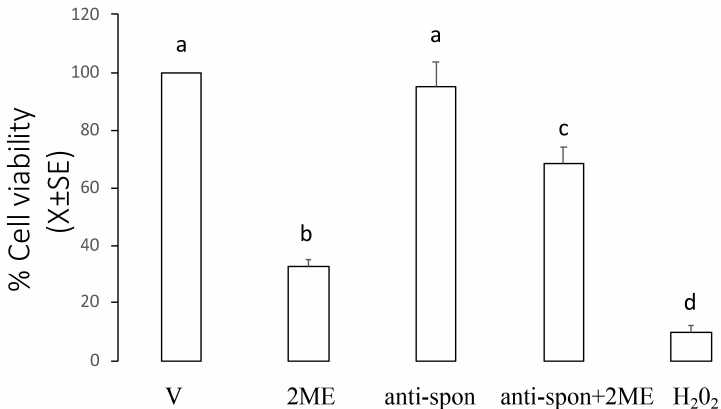
Figure 6. F ‐ spondin neutralizing antibody blocked the 2ME ‐ induced apoptosis in the Ishikawa cells. Cultures of Ishikawa cells were divided into the following treatment groups: culture medium + DMSO (V, control group), 2ME + DMSO (2ME), culture medium + F ‐ spondin antibody (anti ‐ spon), F ‐ spondin antibody + 2ME (anti ‐ spon + 2ME). At 72 h after treatment, cultured cells were processed to measure their viability as described in the Materials and Methods section. Hydrogen peroxide (H 2 O 2 ) was added as positive control of toxicity. This experiment consisted of 5 replicates. a ≠ b ≠ c ≠ d, p < 0.05.